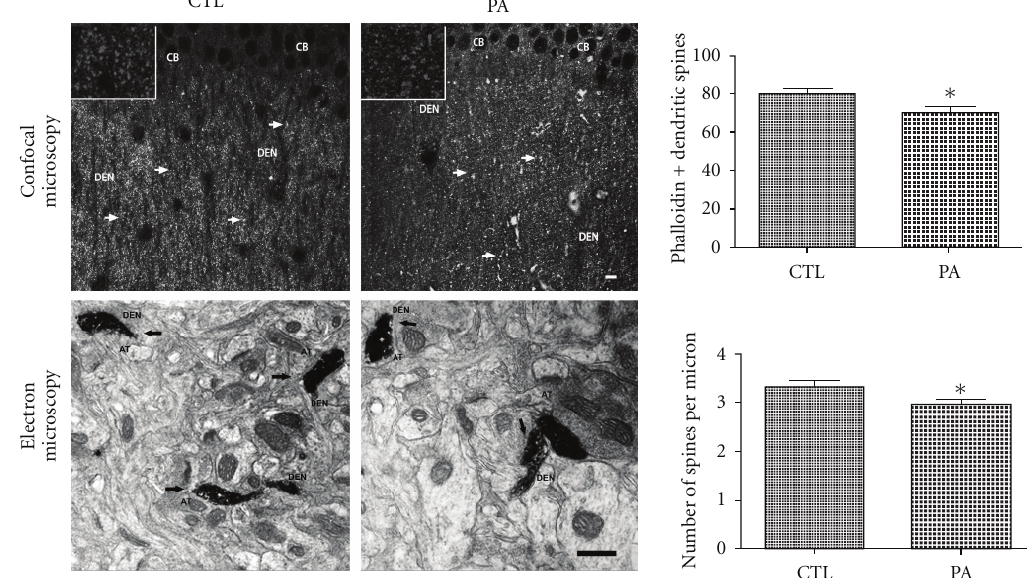
Figure 5: Top : confocal microscope images of Phalloidin-Alexa 568 from Stratum radiatum of CA1 hippocampal tissue from 4-month-old control and asphyctic rats. A decrease in the punctate staining was observed after 19 minutes of PA (arrows). The assessment of the percentage of the reactive area from Stratum radiatum of CA1 hippocampal Phalloidin-Alexa 568 staining in PA rats showed a decrement in the reactivity area staining with phalloidin. ∗ P < 0 . 01. Bars and error bars represent mean + SEM. DEN: dendrites; CB: cell body. Scale bar: 10 μ m. Bottom : electron micrograph of photooxidated area in the Stratum radiatum of CA1 hippocampal tissue of 4-month-old rats. Arrows point out the dendritic spines stained. A decrement in the number of the F-actin-positive spines was observed after 19min of PA. AT: axon terminal; DEN: dendritic shaft. Scale bar: 1 μ m. The graph shows the assessment of the number of spines per field from Stratum radiatum of CA1 hippocampal slices. A significant decrement in the number of positive F-actin spines was observed in the PA group in comparison with the CTL group. ∗ P < 0 . 01. Bars and error bars represent mean + SEM.